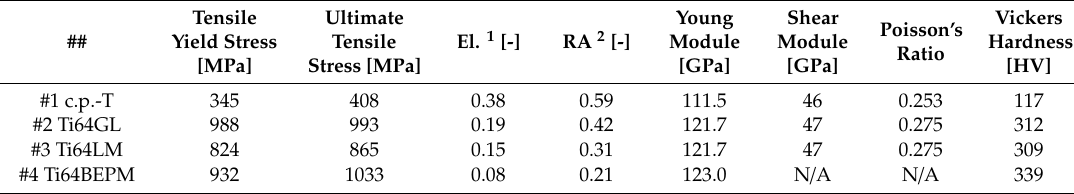
Table 2. Mechanical properties of tested materials (tension rate 8 × 10 − 4 s − 1